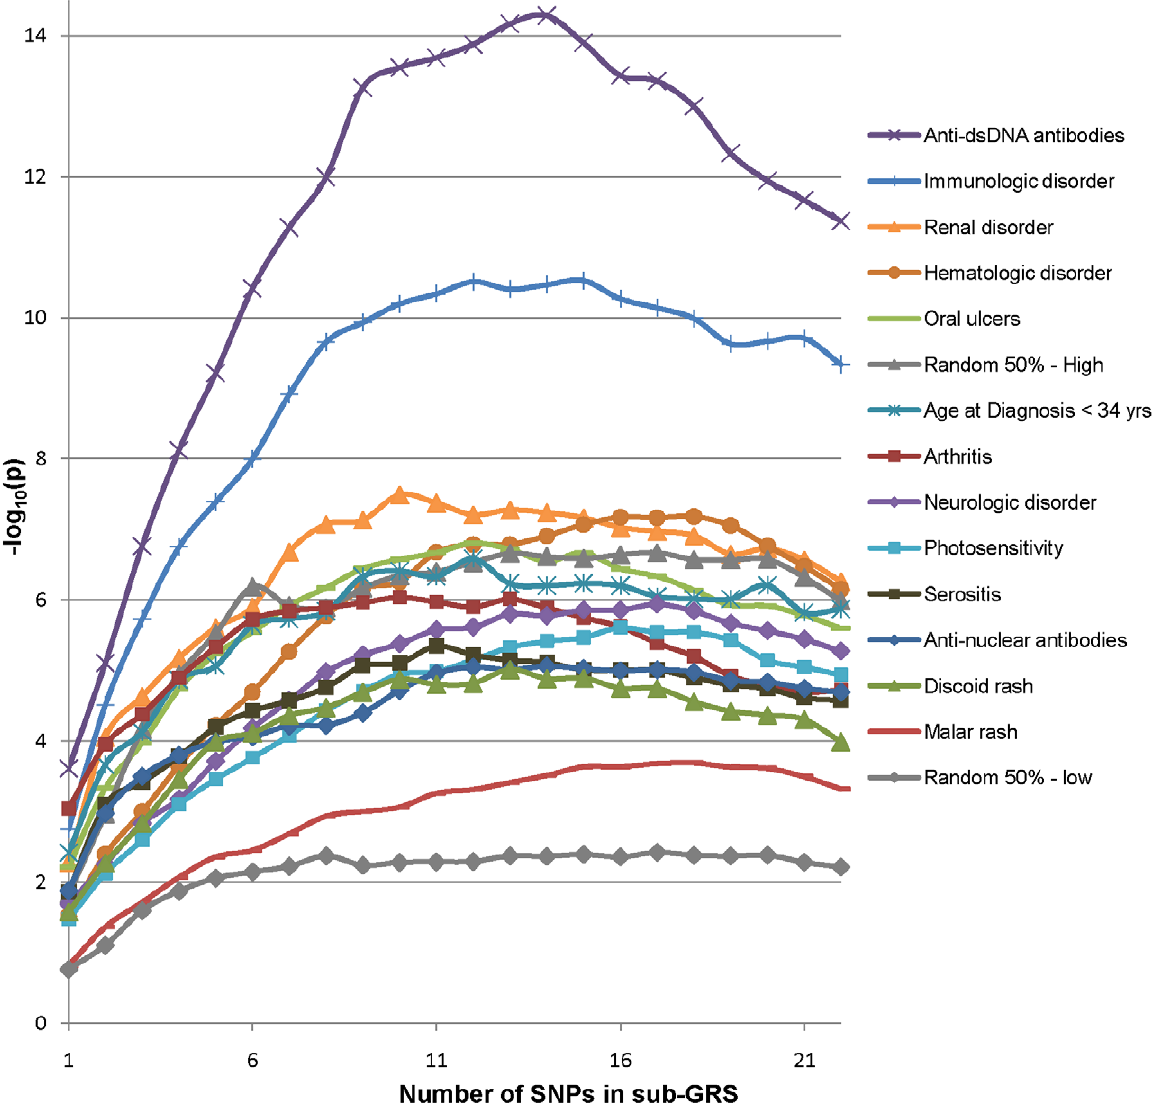
Figure 5. Association of subphenotypes with sub-GRS candidates in study 1, by number of included SNPs. P-values are for likelihood- ratio test of models with sub-GRS plus covariates vs. covariates alone.